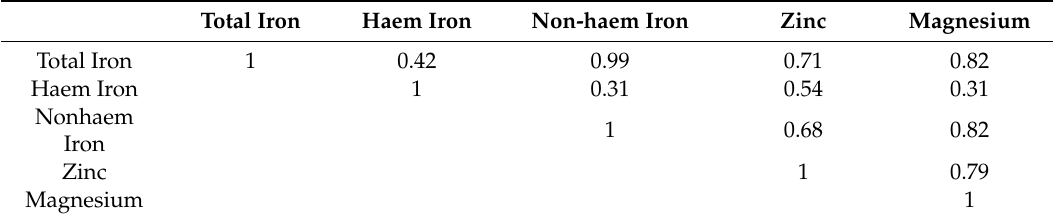
Table 2. Partial correlation coe ffi cients for dietary iron, zinc and magnesium intakes in 5323 participants from the China Nutrition and Health Survey (CNHS) and Shanghai Diet and Health Survey (SDHS) 1,2